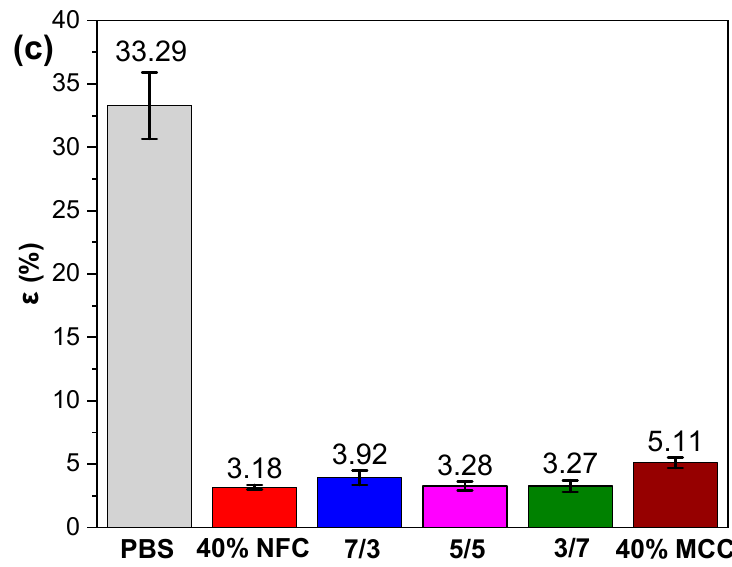
Figure 5. Tensile strength results of PBS and PBS / cellulose composites: ( a ) Elastic modulus E; ( b ) tensile strength σ and ( c ) strain ε .